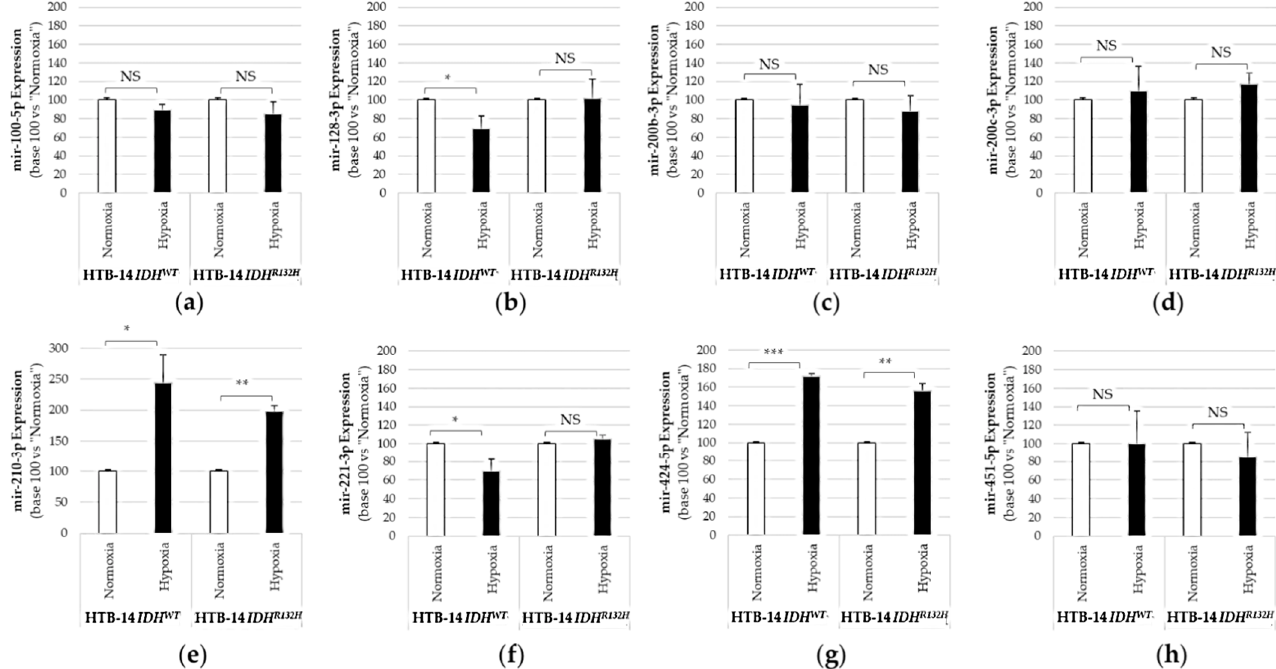
Figure 3. Expression of pro-angiogenic or pro-hypoxic miRNAs in HBT-14 (U-87 MG) IDH1 R132H or in HBT-14 (U-87 MG) IDH1 WT cells grown in hypoxia (1% O 2 , 24 h). HBT-14 (U-87 MG) IDH1 WT and HBT-14 (U-87 MG) IDH1 R132H cells at 60% confluence were cultivated for an additional 24 h in normoxia or hypoxia (0.1% O 2 ). The miRNAs from HBT-14 (U-87 MG) IDH1 WT and HBT-14 (U-87 MG) IDH1 R132H cells were extracted using miRNAeasy (Qiagen™), then retrotranscribed (RT) and amplified (PCR) using the TaqMan MiRNA Reverse transcription kit (Applied Biosystem). The RT-PCR data were normalized to the small nucleolar house-keeping RNA, RNAS RNU48 (SNORD48)